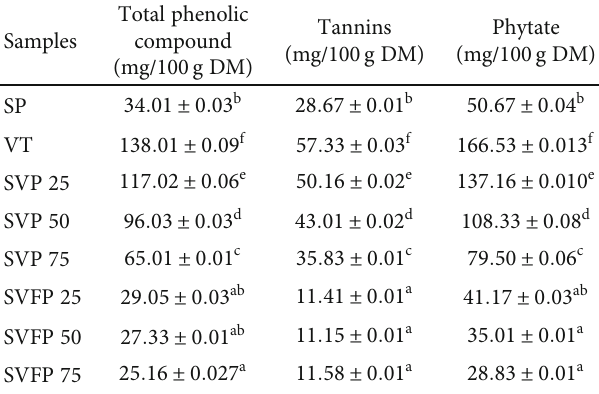
Table 2: Antinutrient composition of precooked fermented and unfermented fl ours.